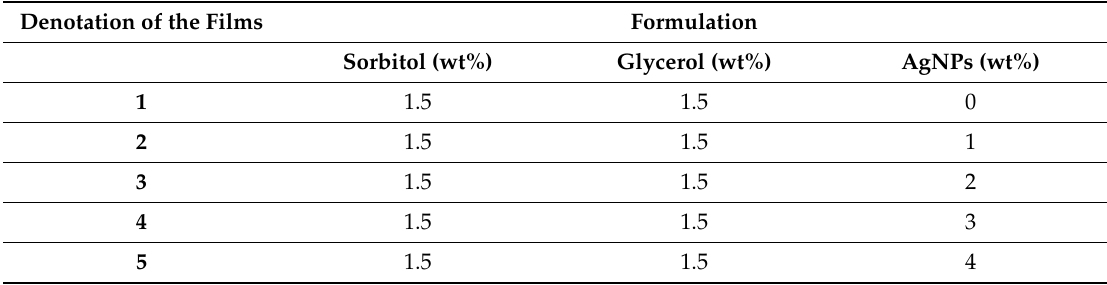
Table 1. Material composition of antibacterial biopolymer composite film. Denotation of the Films